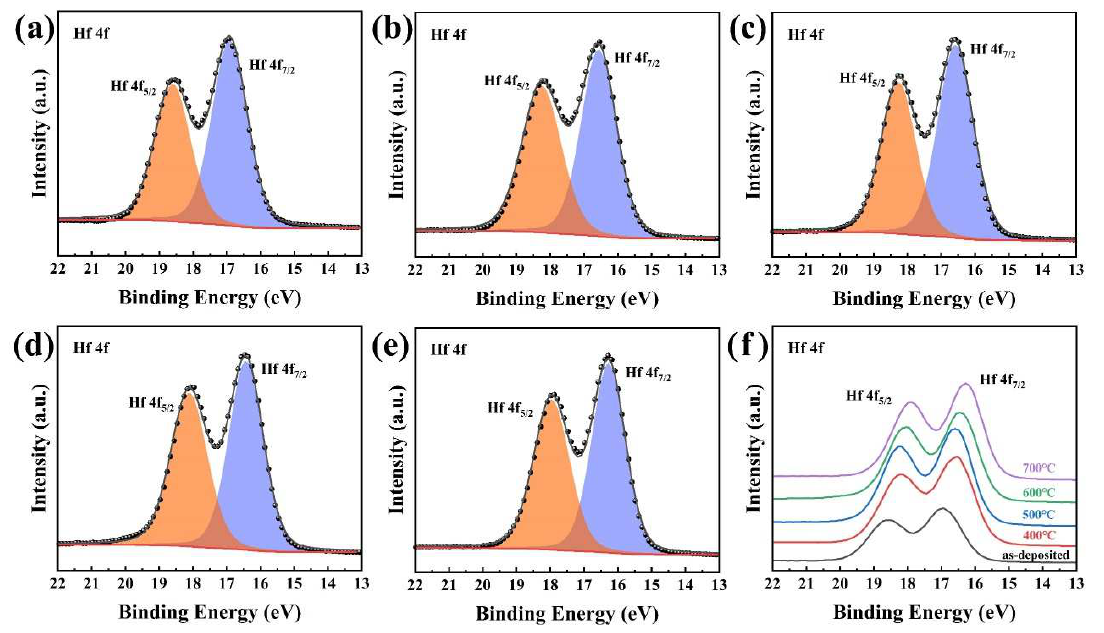
Figure 7. ( a – e ) Hf 4f XPS spectra of lanthanum-doped HfO 2 films at different temperatures. ( f ) Hf 4f XPS spectral stacking diagram.